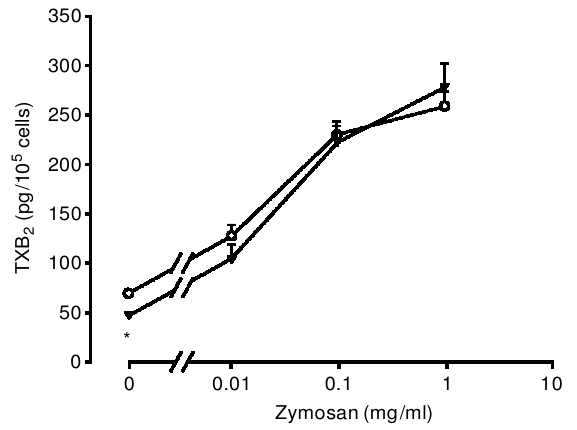
FIG. 3. The effect of the incubation with opsonized zymosan (0.01 ± 1 mg / ml) in the absence (open circles) or presence (® lled circles) of dexamethasone (10 m M), for 4 h, on the TXB 2 release. P , 0.05, compared with the control. n > 6.